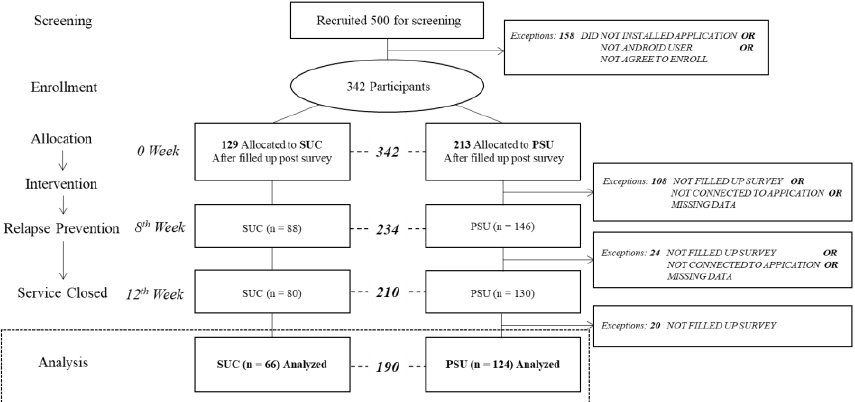
Figure 2. Participant enrollment flow